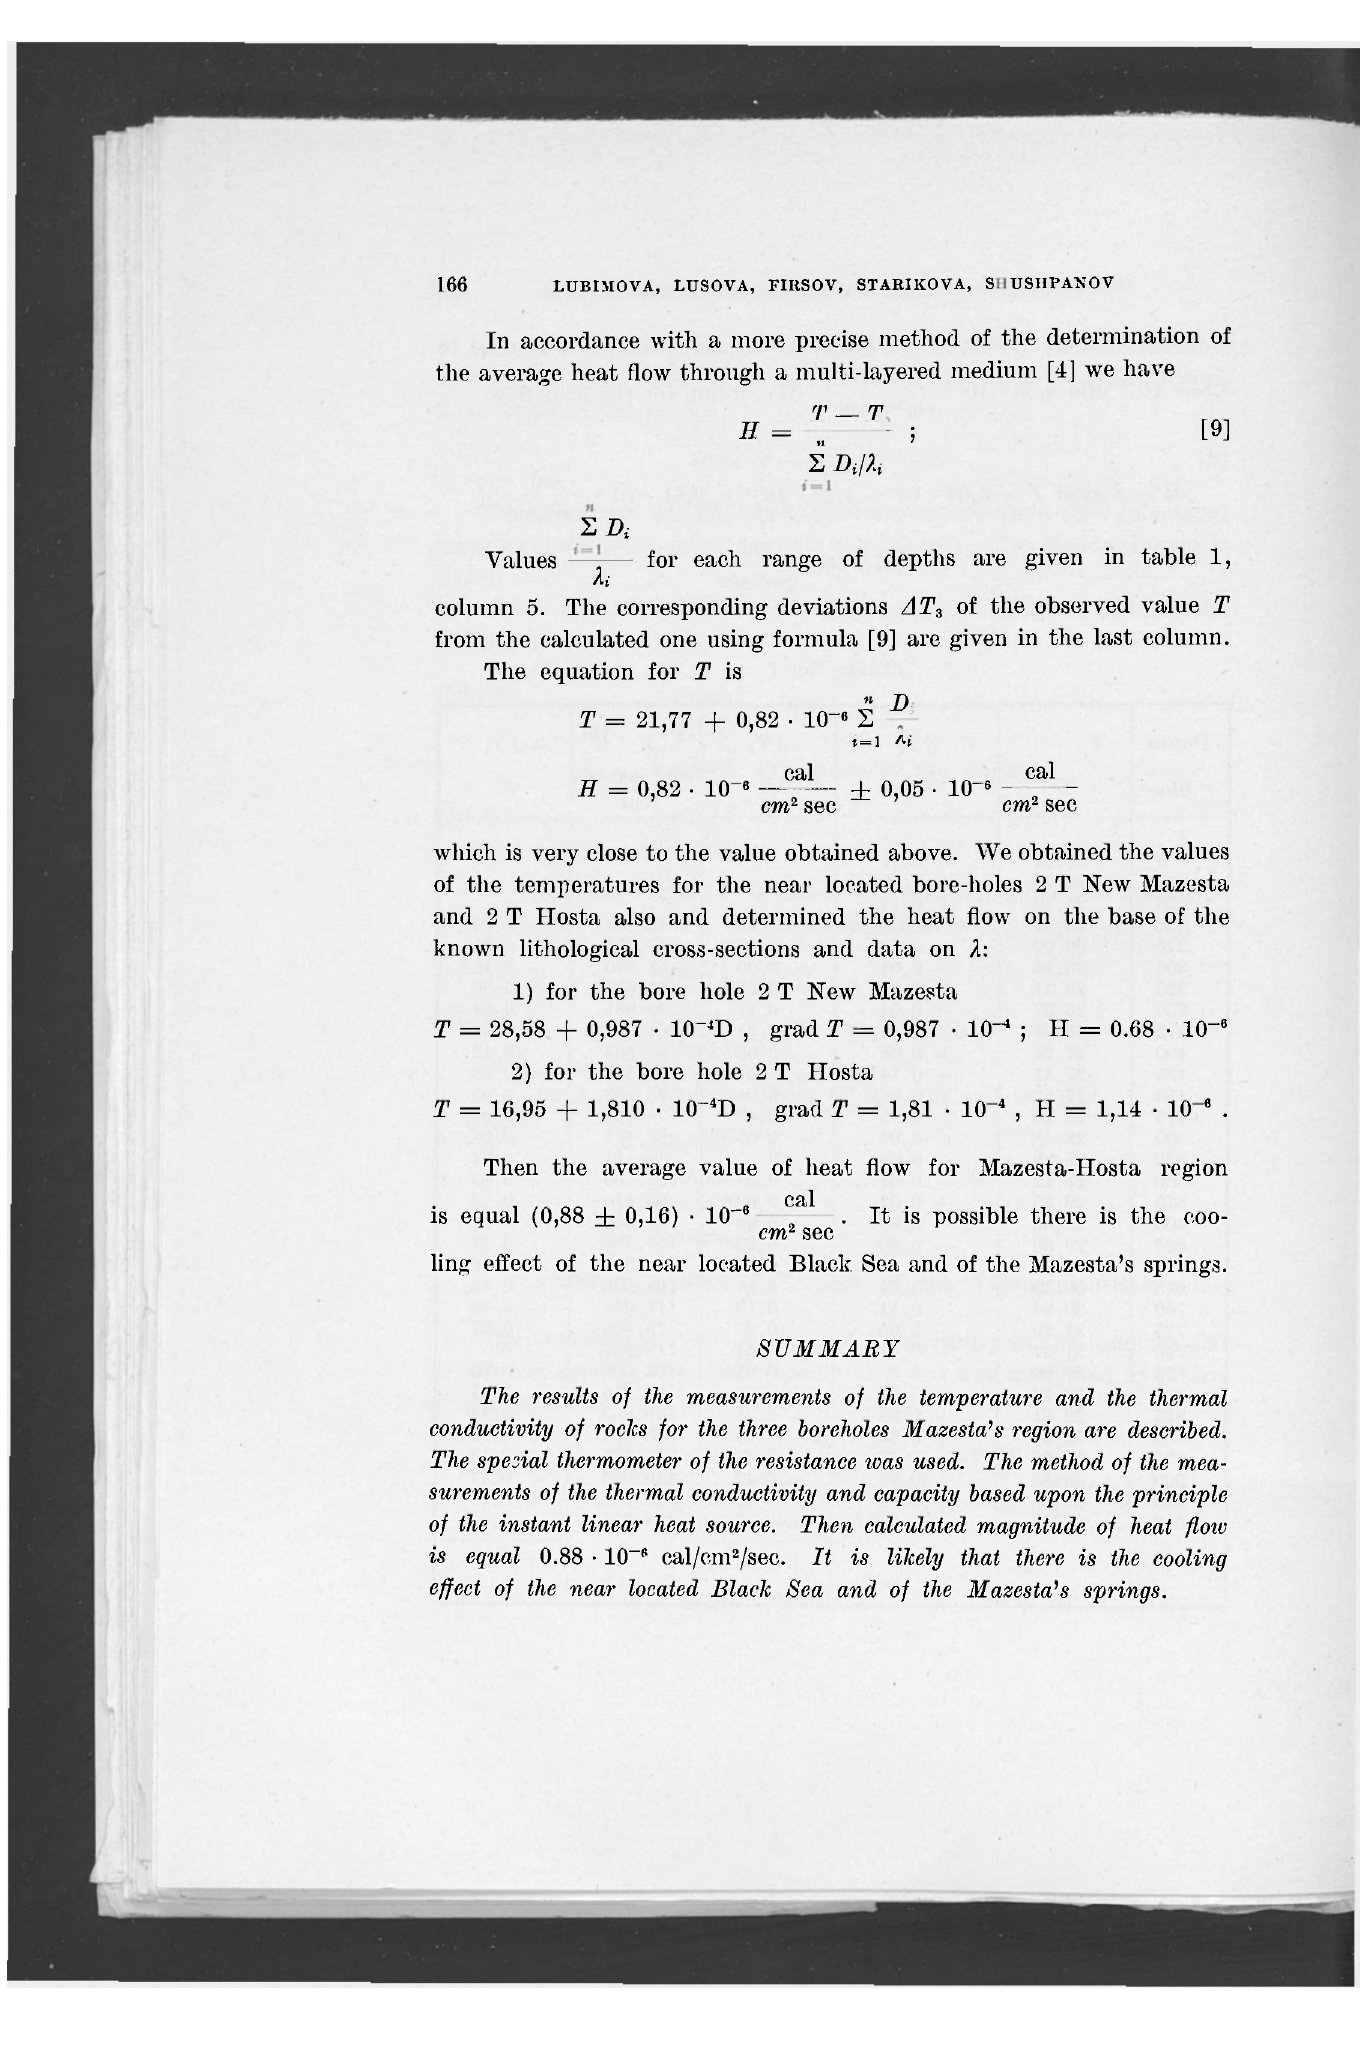
from the calculated one using formula [9] are given in the last